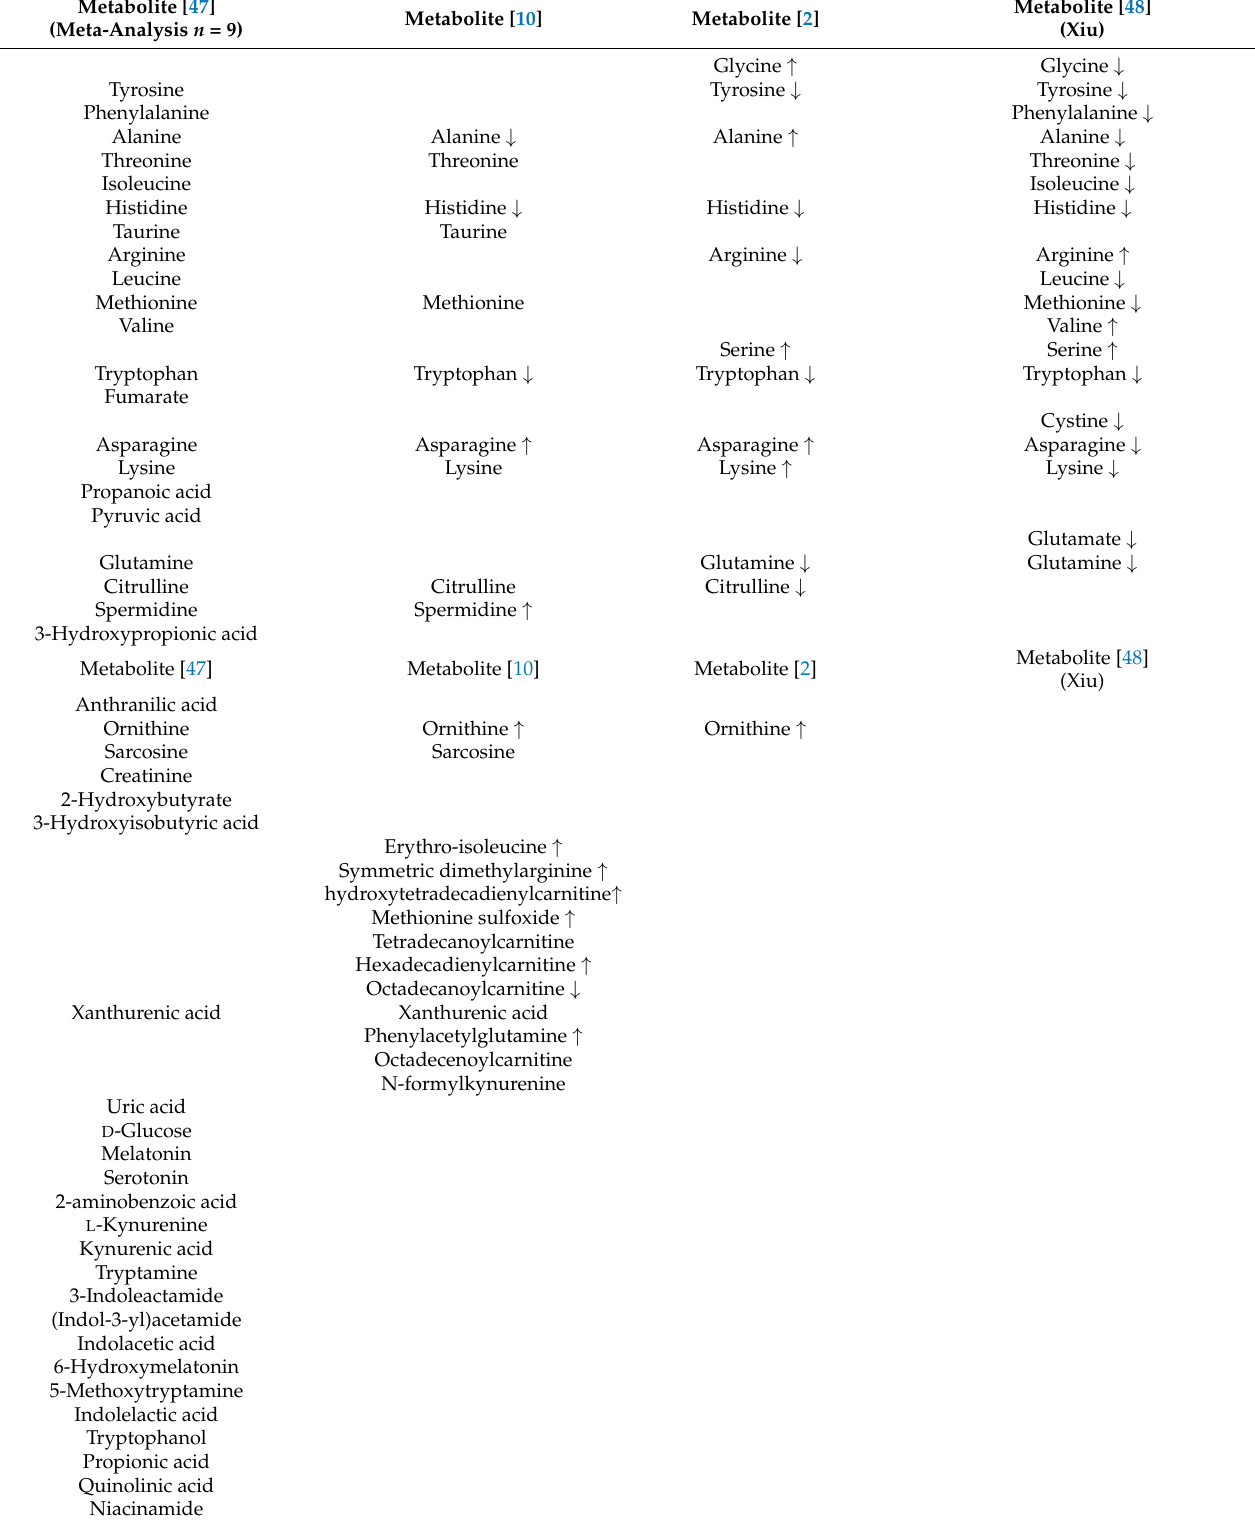
Table 2. Differential metabolites (GC vs. non-GC) for gastric